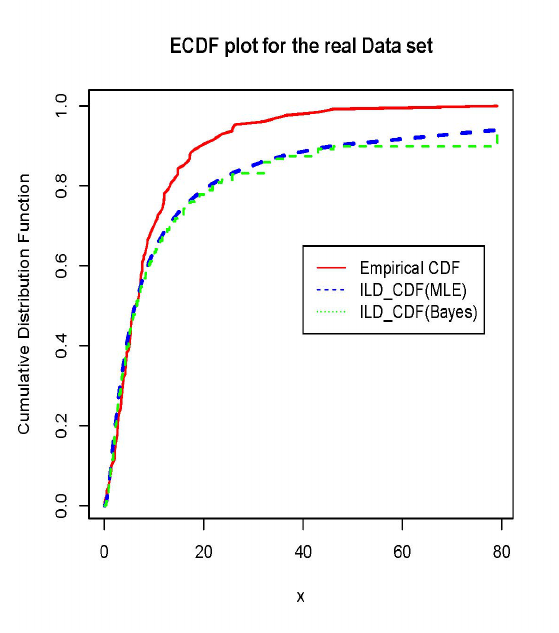
Figure 1 – Empirical cumulative distribution function plot for the data set-I.